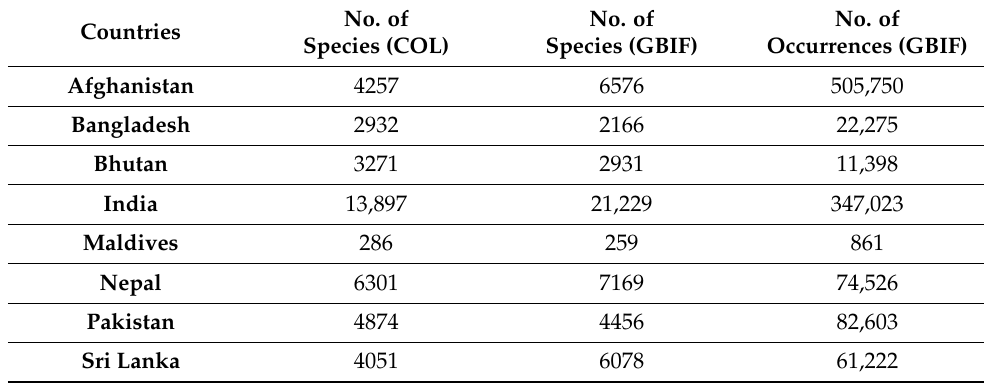
Table 3. Statistic numbers for the vascular plants of South Asia from the GBIF (2020).